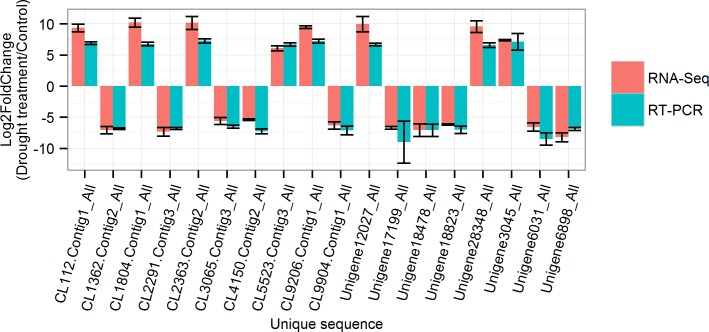
Verification of 18 putative genes that are involved in the drought response by qRT-PCR.The left Y-axis indicates the normalized expression pattern of the DEGs under drought. Error bars represent ±1 SE.